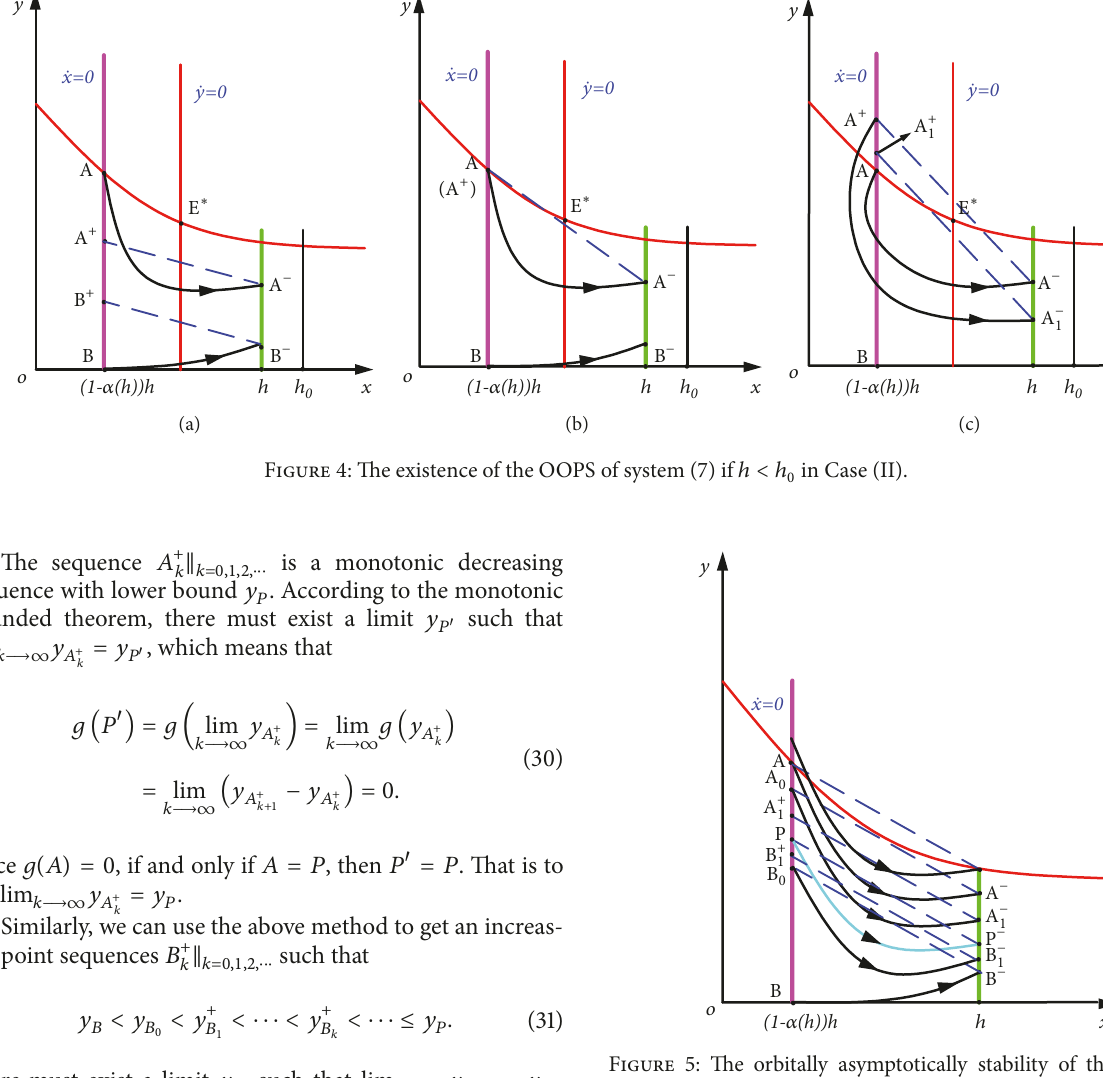
Figure 5: The orbitally asymptotically stability of the OOPS of system